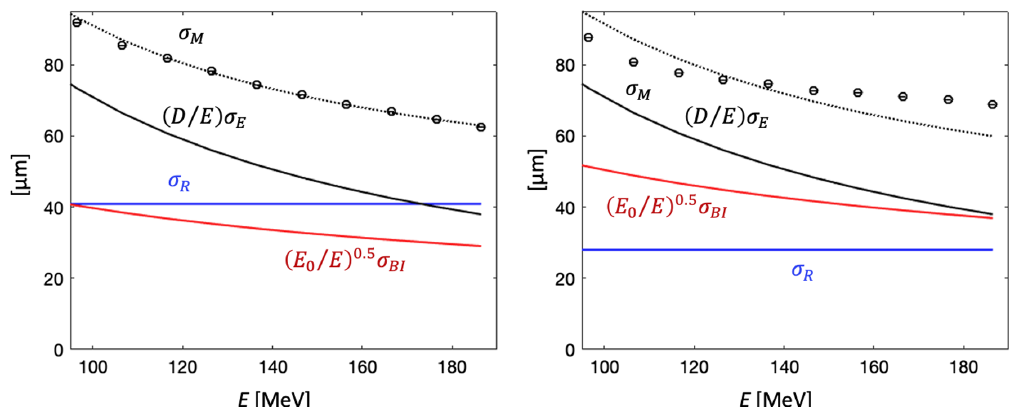
FIG. 10. The left plot shows the results for the beam matched at each energy. The right plot shows the results for the beam matched only at the reference energy E 0 ¼ 130 MeV. The black circles show the slice width σ M from the simulations. The black dotted line in the left plot shows the results of the reconstruction with Eq. (7). The other lines in this plot show contribution of different terms. For the data shown in the right plot the reconstruction is impossible. The lines show the expected values calculated using the true data